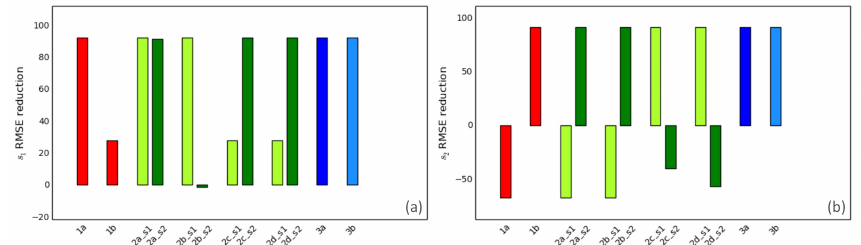
Figure 6. Reduction in RMSE for all test cases for both (a) s 1 and (b) s 2 variables for the non-linear toy model simulations with no model bias. For the step-wise cases (2a, b, c and d) the reduction after both step 1 and step 2 are shown in light and dark green, respectively, and are denoted in the x axis labels with “_s1” for step 1 and “_s2” for step 2. The reduction (in %) is calculated as 1 − (RMSE prior / RMSE post ).